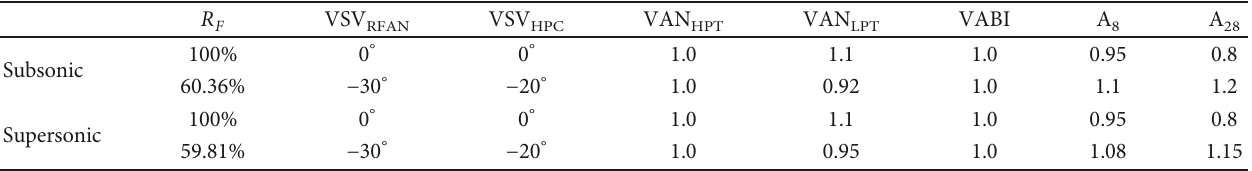
Table 8: Control schedule of variable geometries (group